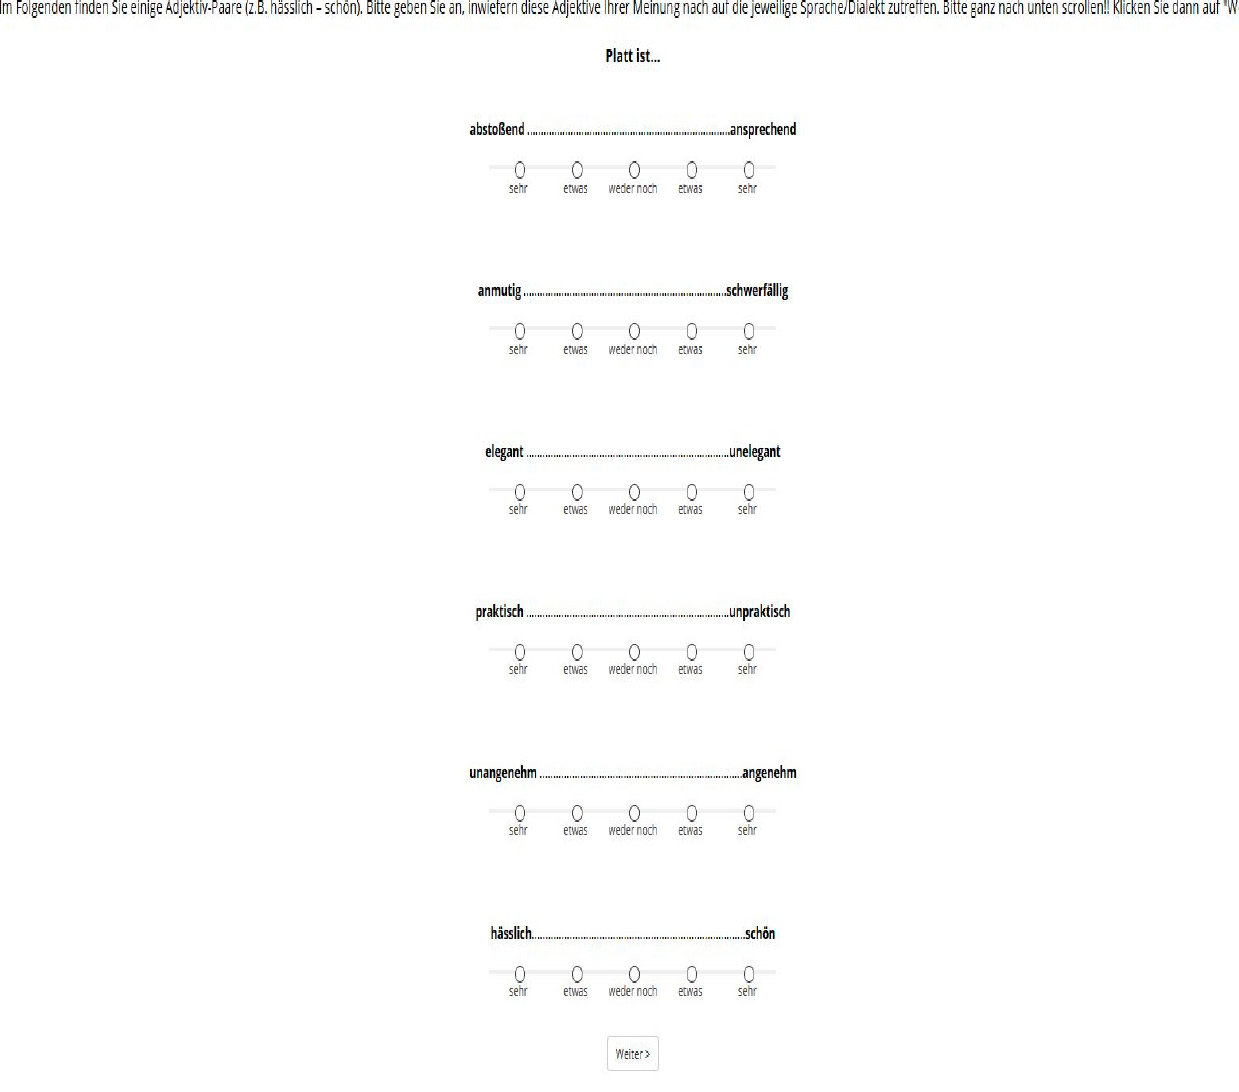
Figure A1. Semantic differential scales to measure attitudes towards the vernacular in Belgium.